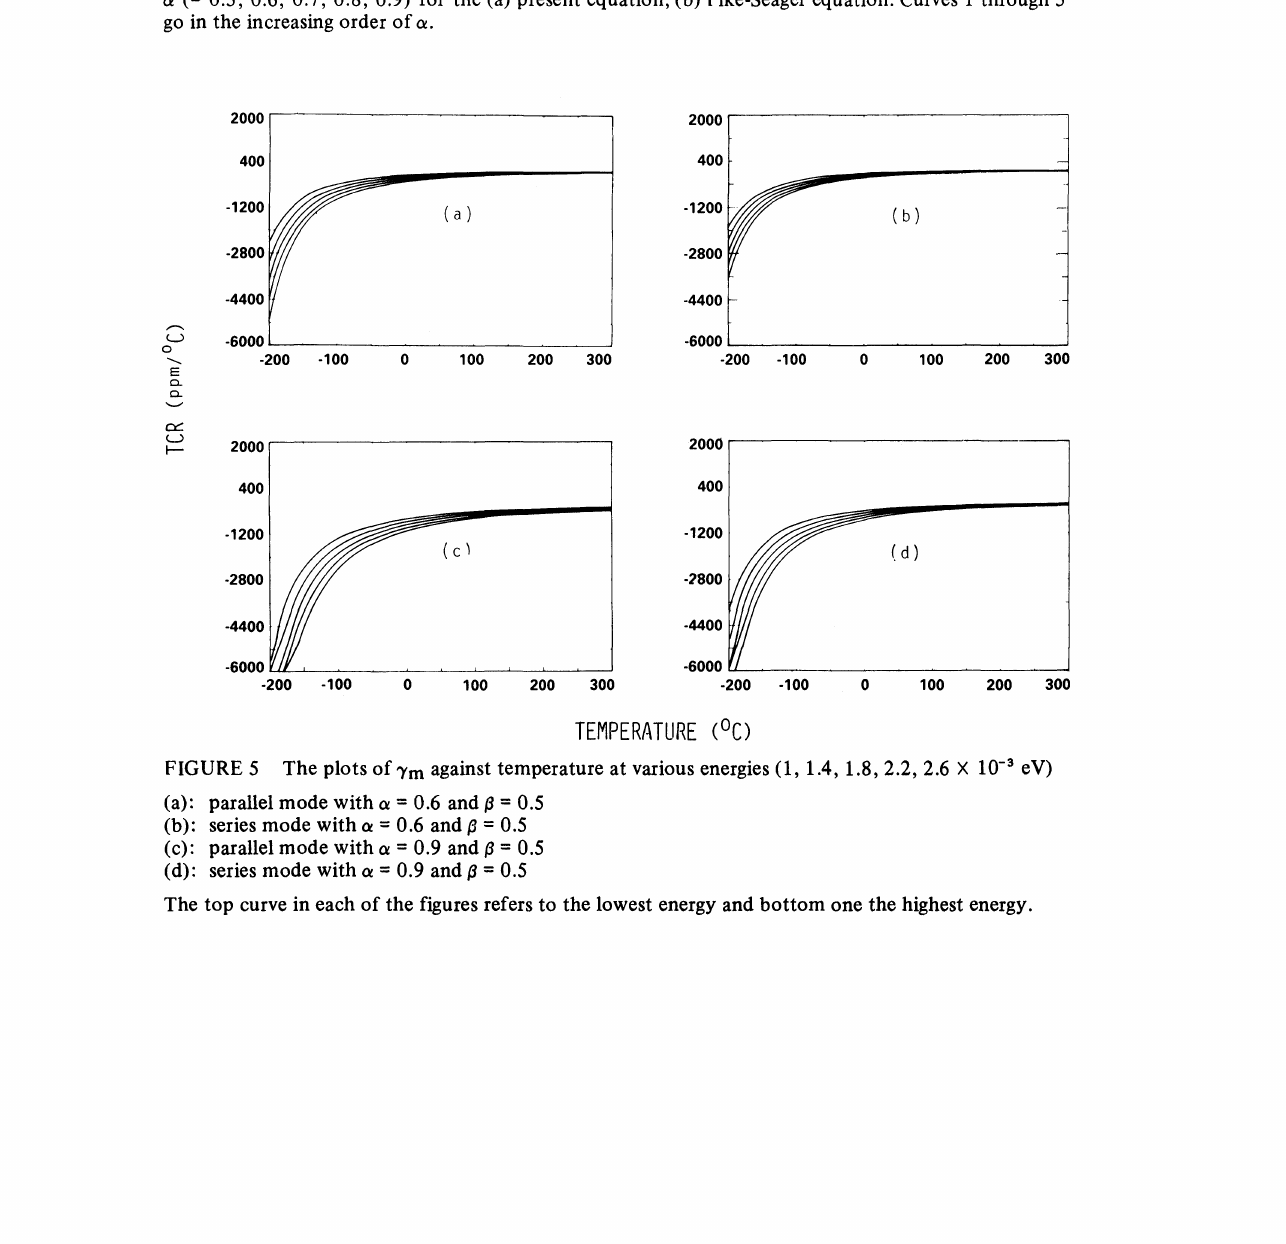
The plots of activation energies against temperature minimum at various values of a (= 0.5, 0.6, 0.7, 0.8, 0.9) for the (a) present equation, (b) Pike-Seager equation. Curves through 5 go in the increasing order of a.